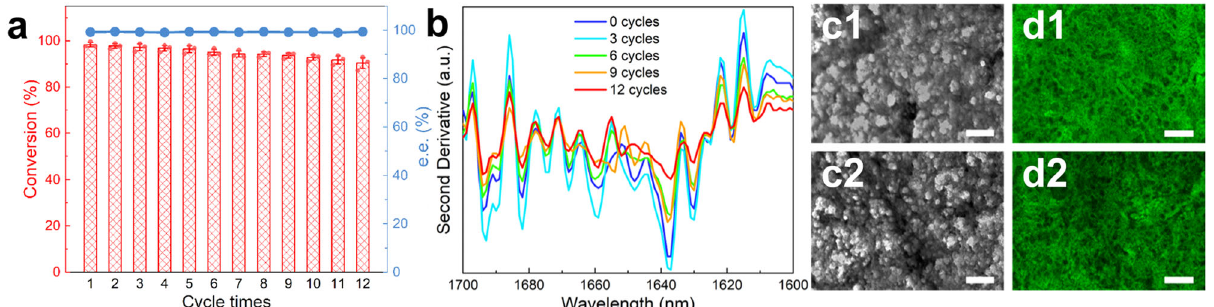
Fig. 4 | Reusability of EAG. a Conversions and enantiomeric excess (e.e.) values measured during 12 reaction cycles using EAG as the catalyst. n =3. Data are expressed as the mean±SEM. b Second derivatives of the FTIR spectra of EAG obtained after different numbers of cycles. c TEM images of the lyophilized EAG